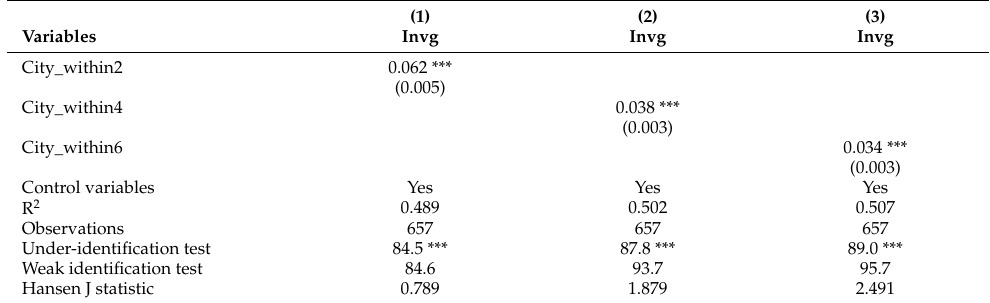
Table 9. The robustness test of the baseline model when all explanatory variables lagged for three